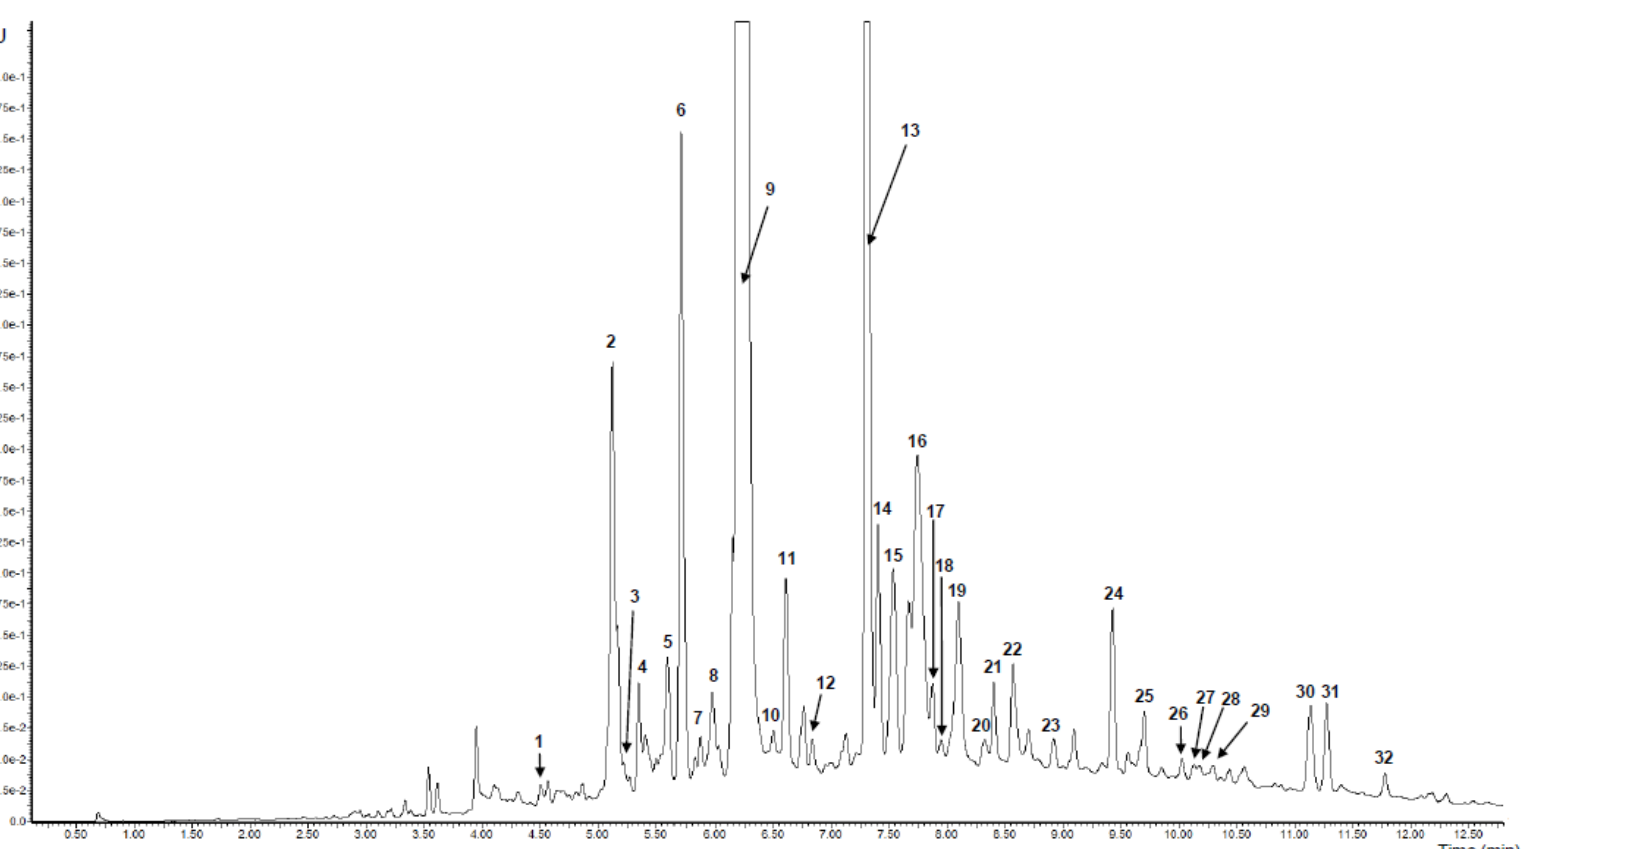
Figure 1. UPLC chromatogram of purified V. opulus juice (PJ) at 280 nm. Refer to Table 1 for the identification of each numbered peak.